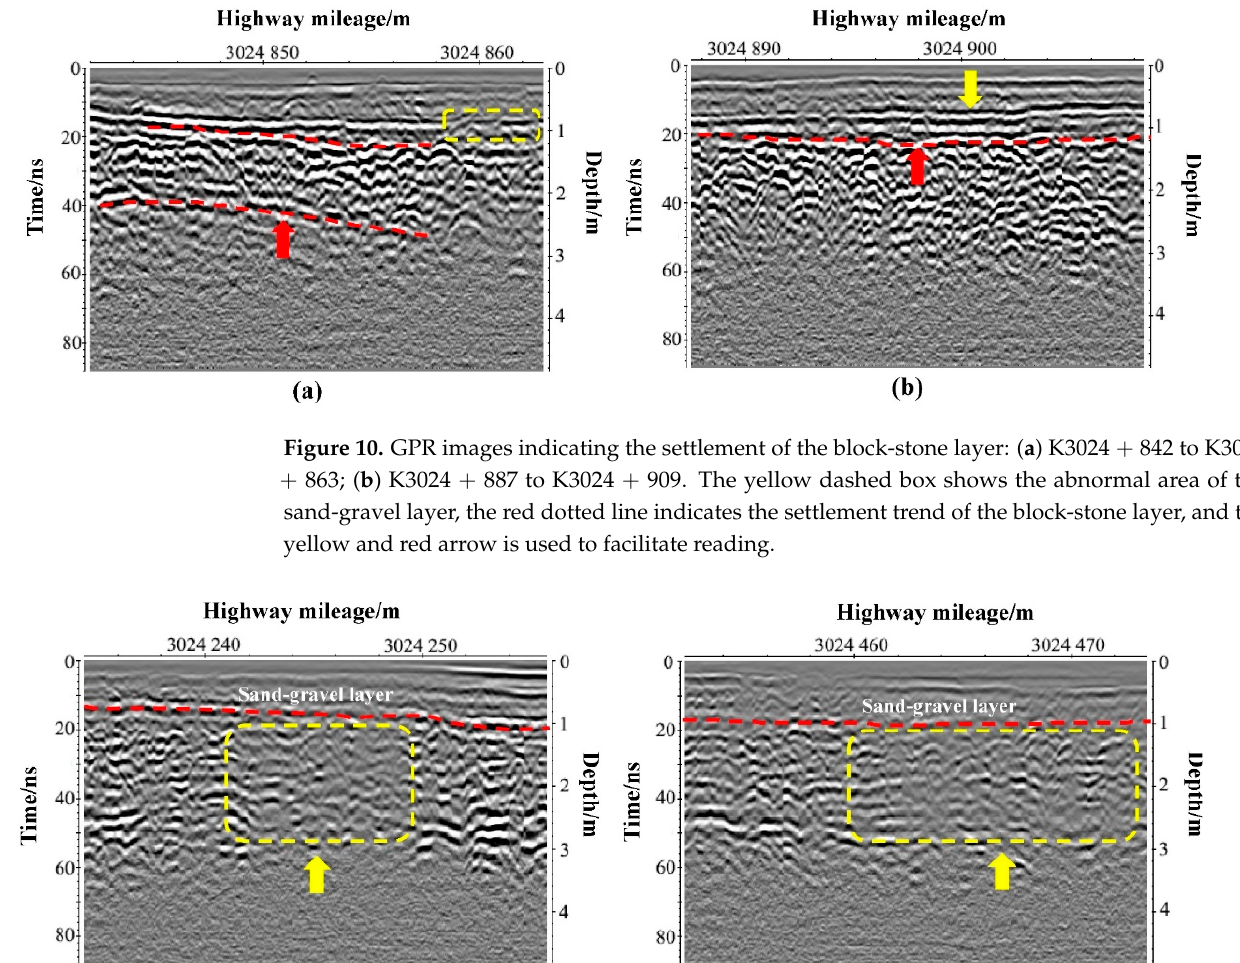
Figure 12. Comparison of the results of different processing methods for abnormally dense areas: ( a ) processed according to the normal flow; ( b ) after direct wave removal only gain processing was performed; ( c ) only horizontal signals were removed based on the previous step; ( d ) only moving- average processing was performed based on the previous step. The yellow arrow is used to increase visibility. 4.2. Distribution of Damages to the Block-Stone Embankment The distribution of different types of damage, the overall condition of the embank- ment, and the relationship between various damages were studied in the K3024 to K3025 section of the block-stone embankment to further study the damage properties.